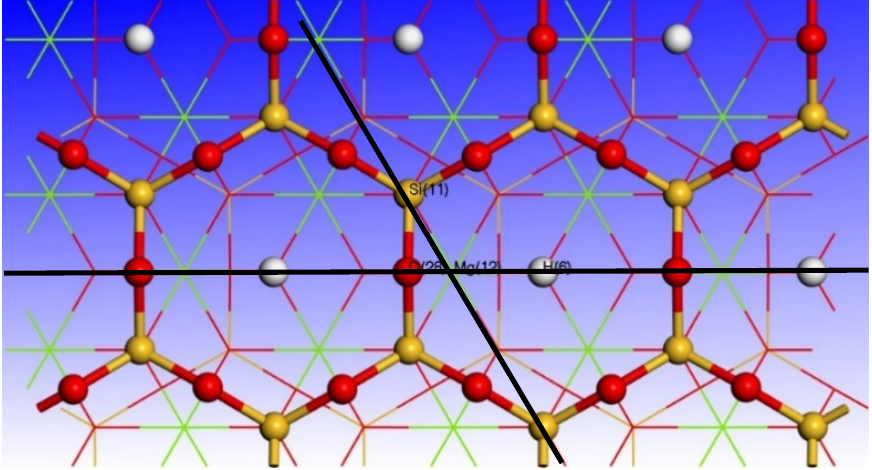
Figure 6. Schematic diagram of charge density cutting.